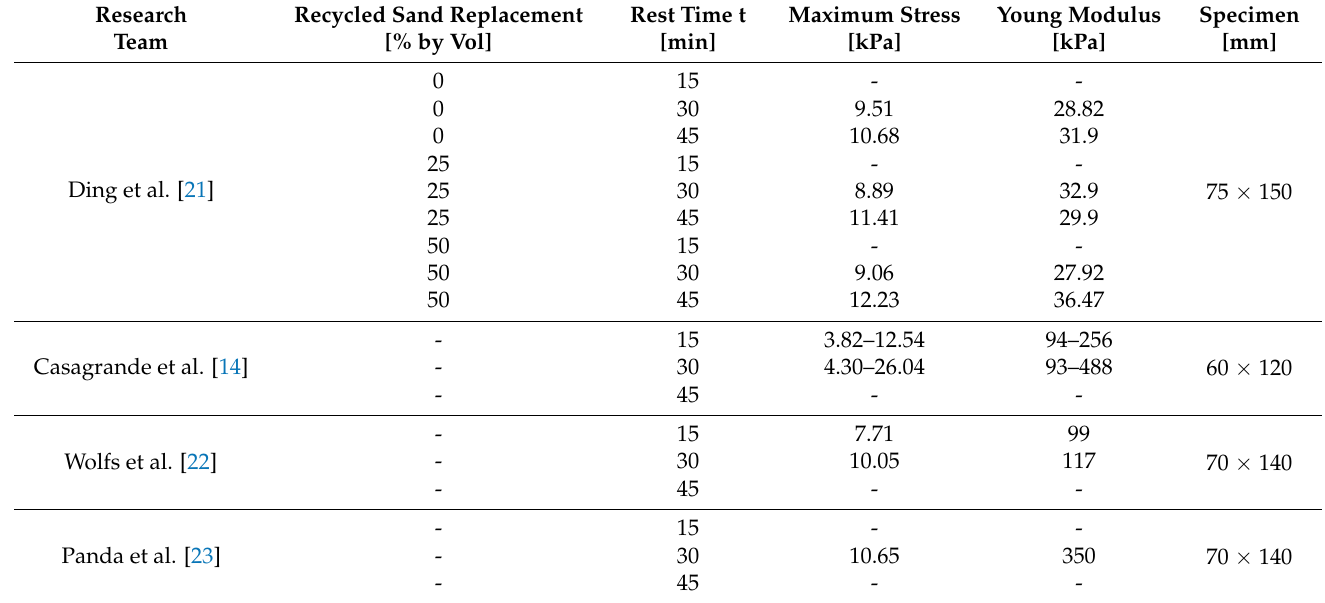
Table 6. Evaluation of green strength in different